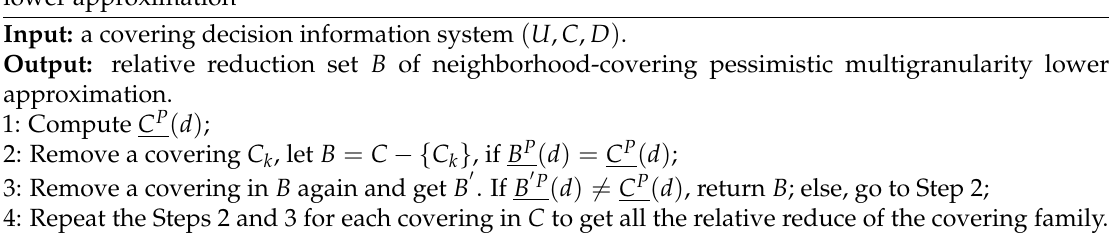
Algorithm 1 Relative reduction algorithm of neighborhood-covering pessimistic multigranularity lower